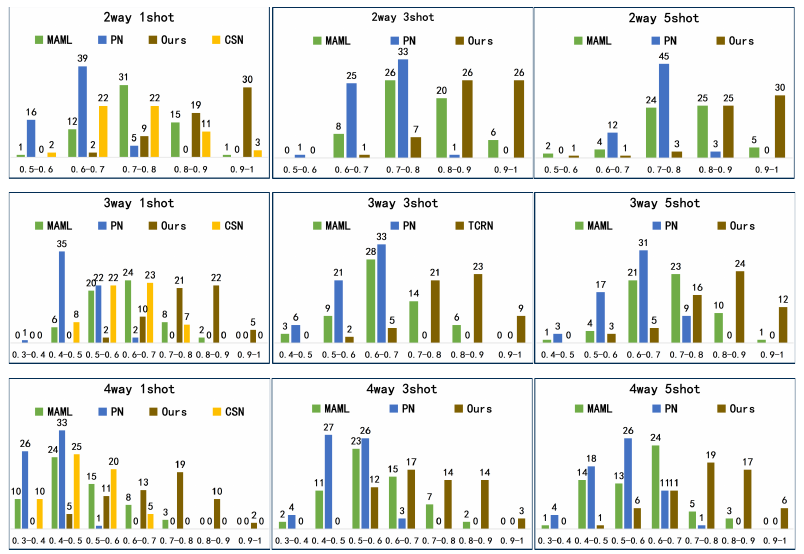
Figure 6. Statistical histograms of the results of 60 trials of our method and baselines in 9 sets of experiments. Each subplot shows the distribution of the results of 60 experiments for each model in different value intervals. The horizontal coordinates in the subplot are value